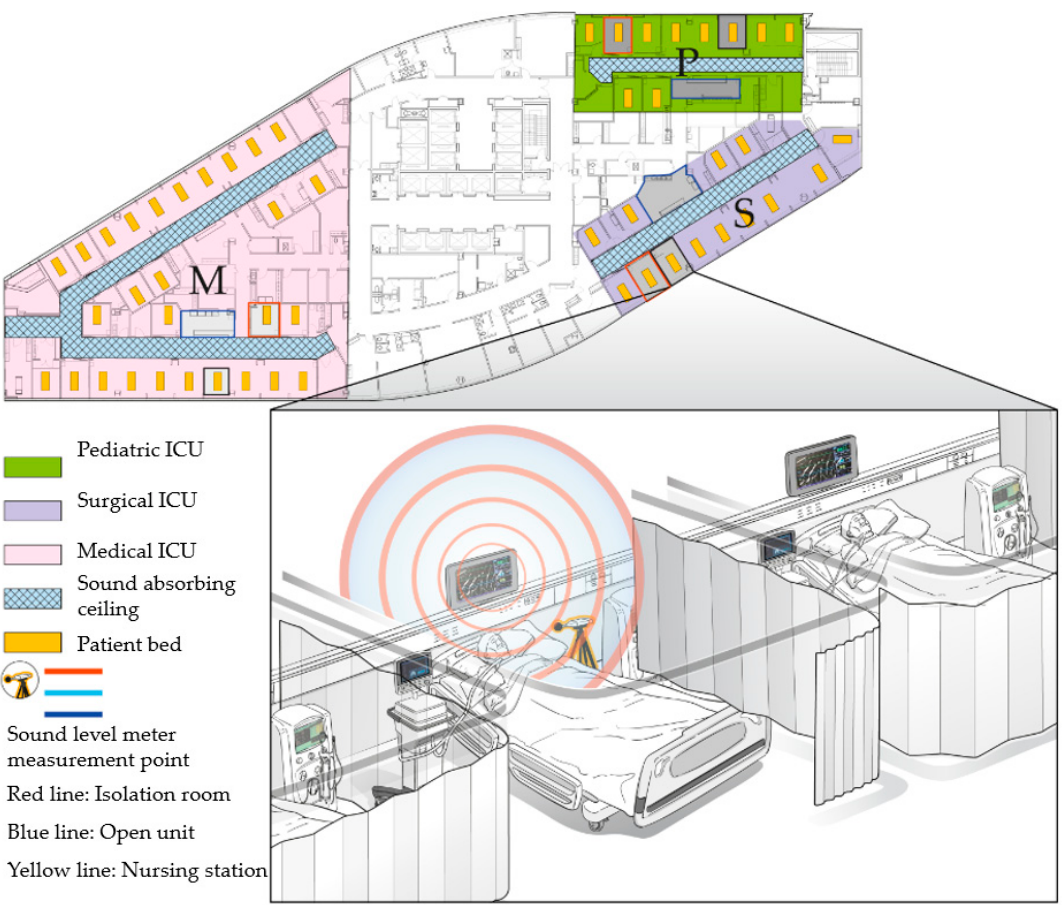
Figure 1. Map of the intensive care unit (ICU) and sound level meter measurement points. The sound pressure level (SPL) measurements were continuous at three points: band during the day (06:00–14:00), evening (14:00–22:00), and night (22:00–06:00), according to the three work shifts of the nurses. The sound levels were recorded every second over eight days at each location.